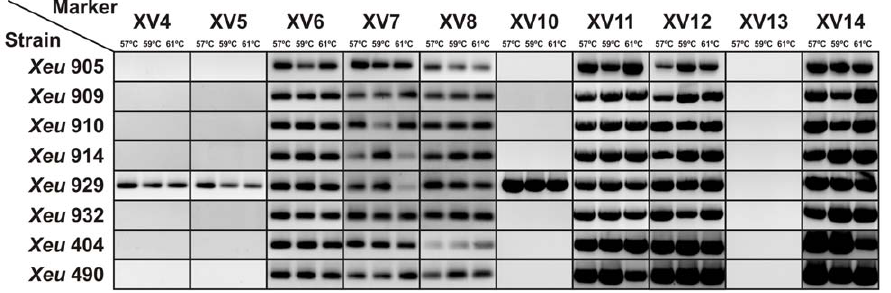
Figure 2. PCR validation. The selected primer-pairs were tested for efficiency using eight different Xeu strains. For each assay, three different annealing temperatures were tested: 57 u C, 59 u C and 61 u C.